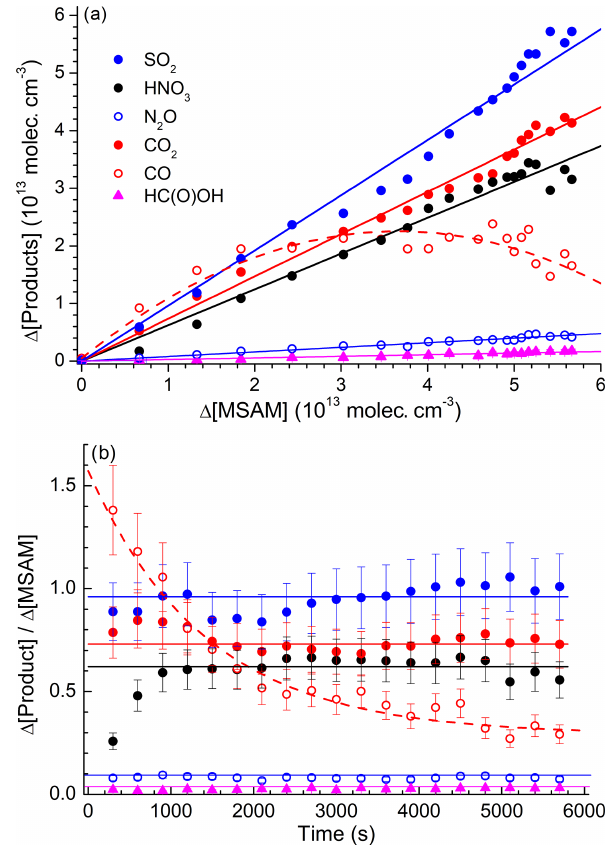
Figure 6. (a) Formation of products versus depletion of MSAM. The slopes of the linear fits are the yields of SO 2 , HNO 3 , CO 2 , N 2 O, and HC ( O ) OH from this particular experiment. The polyno- mial fit to the CO data (red dash line) is added to guide the eye. (b) Time dependence of the product yields from the same experi- ment. The solid, horizontal lines represent the average yield. Error bars are total estimated uncertainty (2 σ ) including uncertainty in cross sections of products and